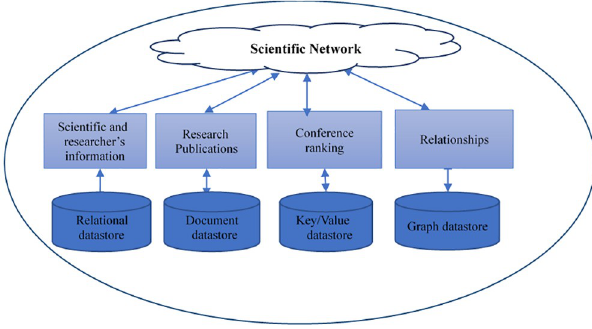
Fig 1. Connecting heterogenous data sets to social